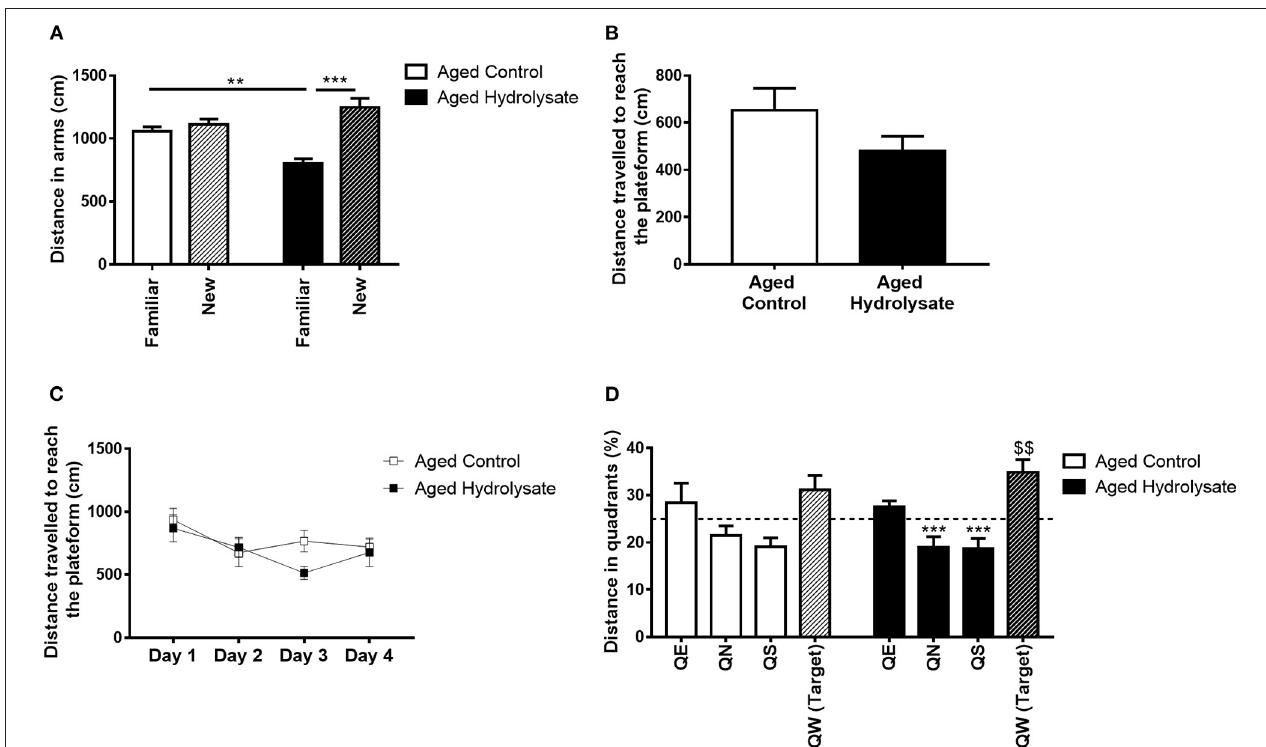
FIGURE 3 | Effects of the fish hydrolysate supplementation on short-term memory, spatial learning and long-term memory. (A) Recognition of the new arm after a 1h ITI in aged mice fed the control diet or the hydrolysate-enriched diet (** p < 0.01, *** p < 0.001 by 2-way ANOVA followed by Tukey post-hoc test). (B) Distance traveled during the cued learning (C) Distance covered to reach the platform over the 4 consecutive days of spatial learning (day effect p < 0.01 by 2-way ANOVA with repeated measures). (D) Percentage of distance traveled in quadrants during the probe test. The dotted line represents chance level (25%) [ $$ p < 0.01 vs. chance level by one-sample t -test. *** p < 0.001 compared to QW (Target) by One-way ANOVA and Dunnett’s multiple comparison test; n = 8 per group]. Data are presented as mean ± SEM. QE, quadrant east; QN, quadrant north; QS, quadrant south; QW, quadrant